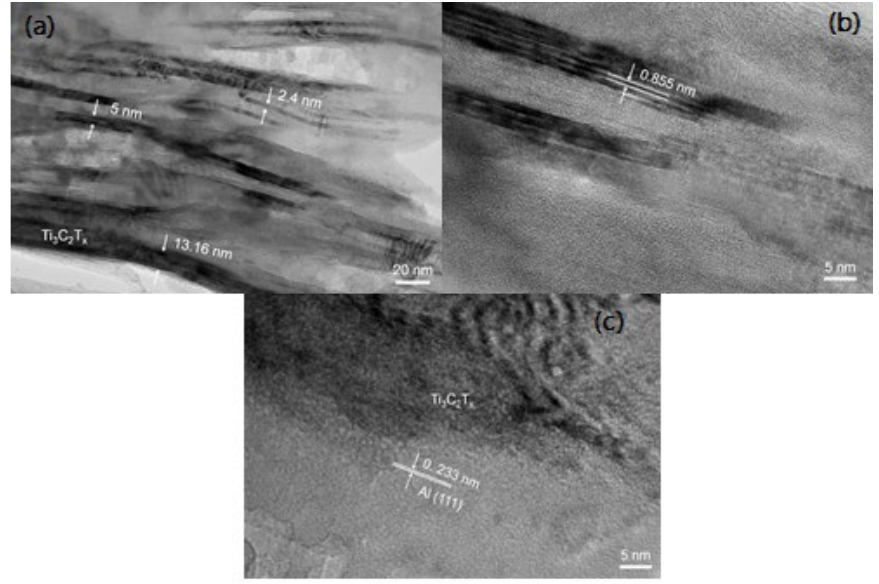
Figure 20. TEM images of the sample sintered at 650 °C. ( a ) A TEM micrograph showing stacked multilayers of Ti 3 C 2 T x , ( b ) a high-resolution TEM (HRTEM) micrograph of Ti 3 C 2 T x , and ( c ) a HRTEM micrograph of Ti 3 C 2 T x /Al interface. Reprinted with permission from [71]. Copyright 2018 materials MDPI.